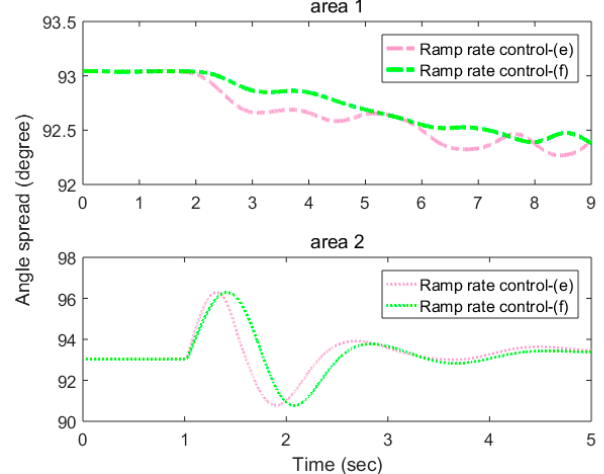
Figure 13. Angle spread results of each area according to (e) and (f) in Table 1.